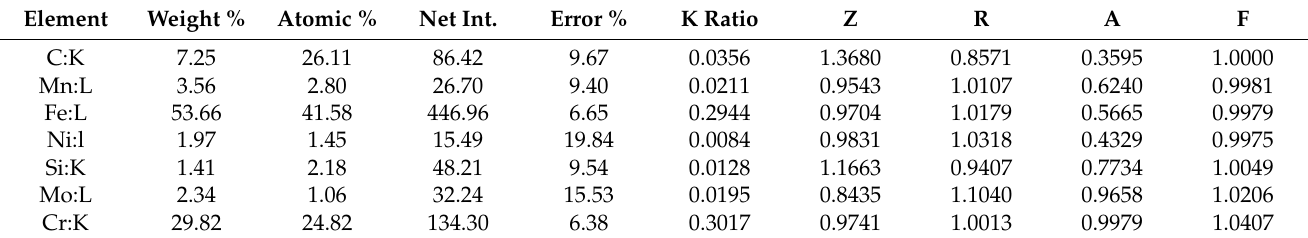
Table 4. Chemical composition as the result of EDS analysis in specimen No. 1 (second point).